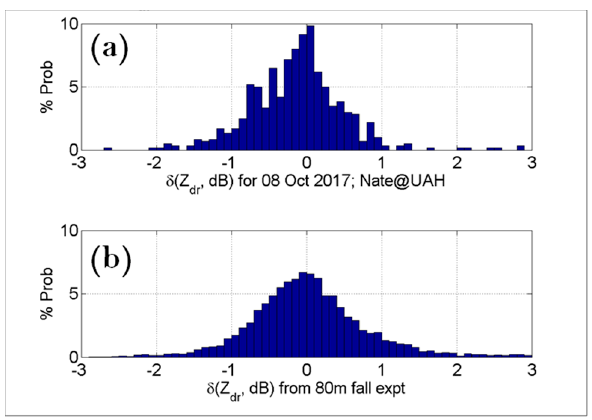
Figure 8. Histograms of δ (Z dr ) for all >2.5 mm drops ( a ) for the reconstructed drops from the outer rain bands of TD Nate and ( b ) for drops recorded during the 80 m fall experiment [4] using Equation